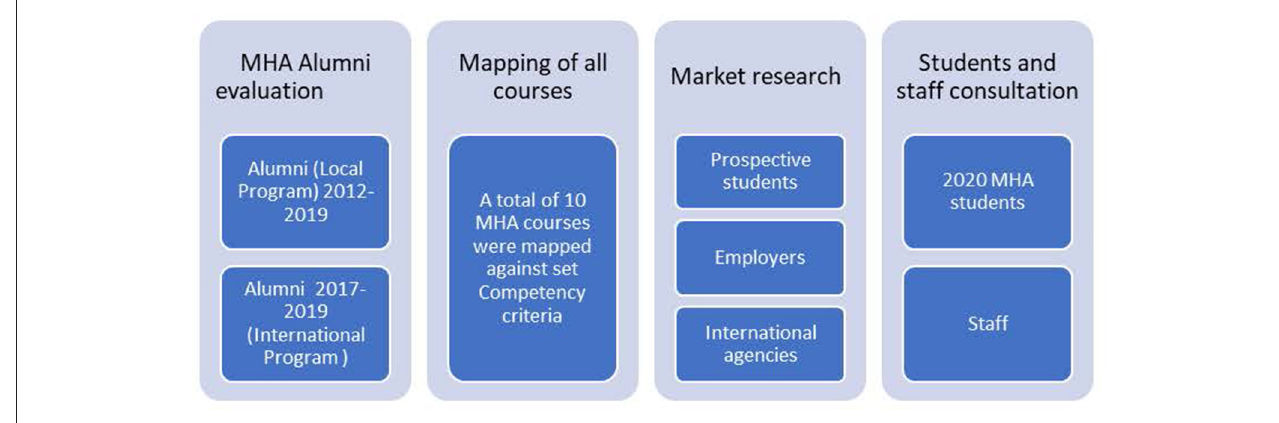
FIGURE 1 | Details of the stakeholders involved in the Gap